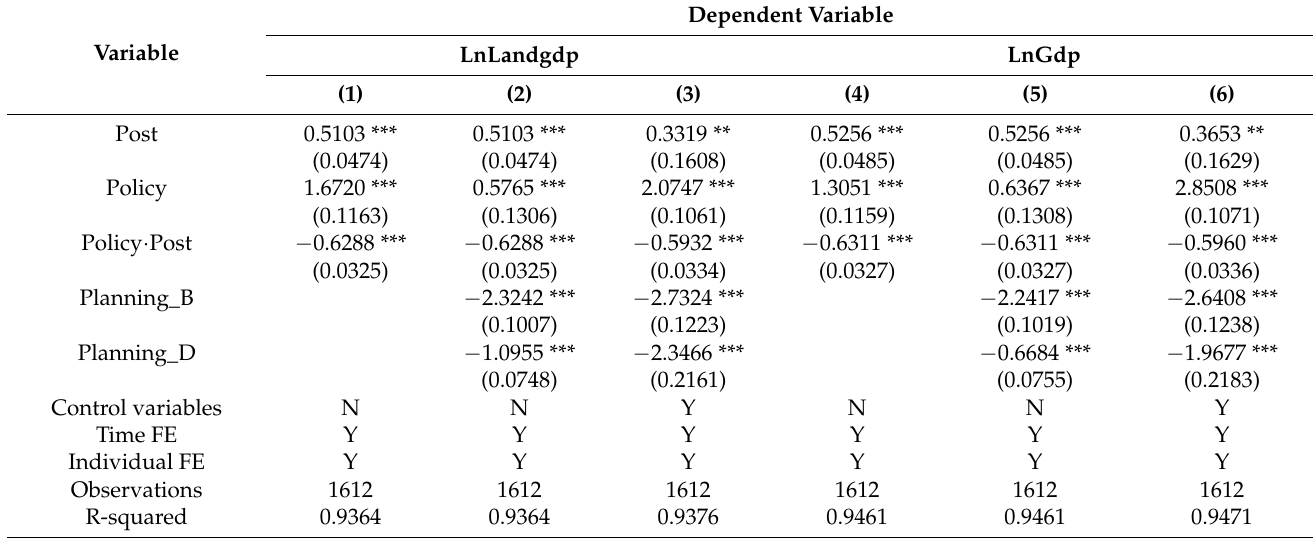
Table 4. Regression results when replacing the dependent